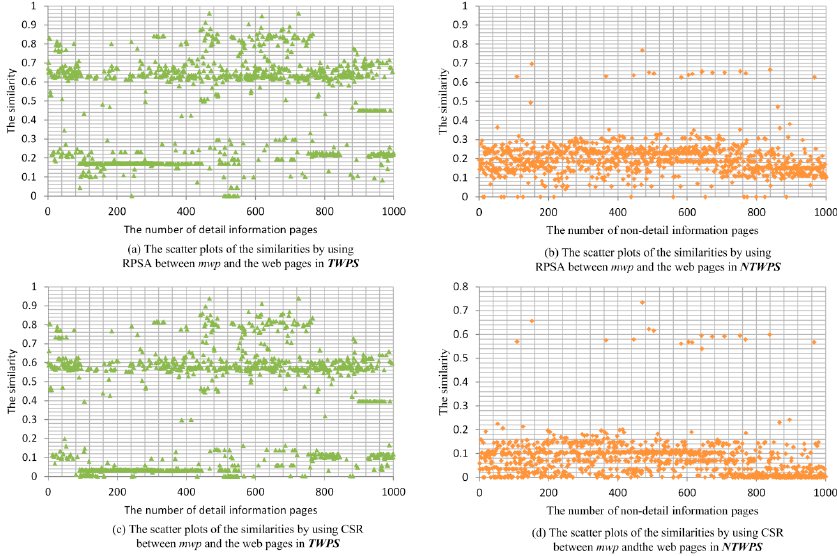
Figure 4. The scatter plots of the similarities.